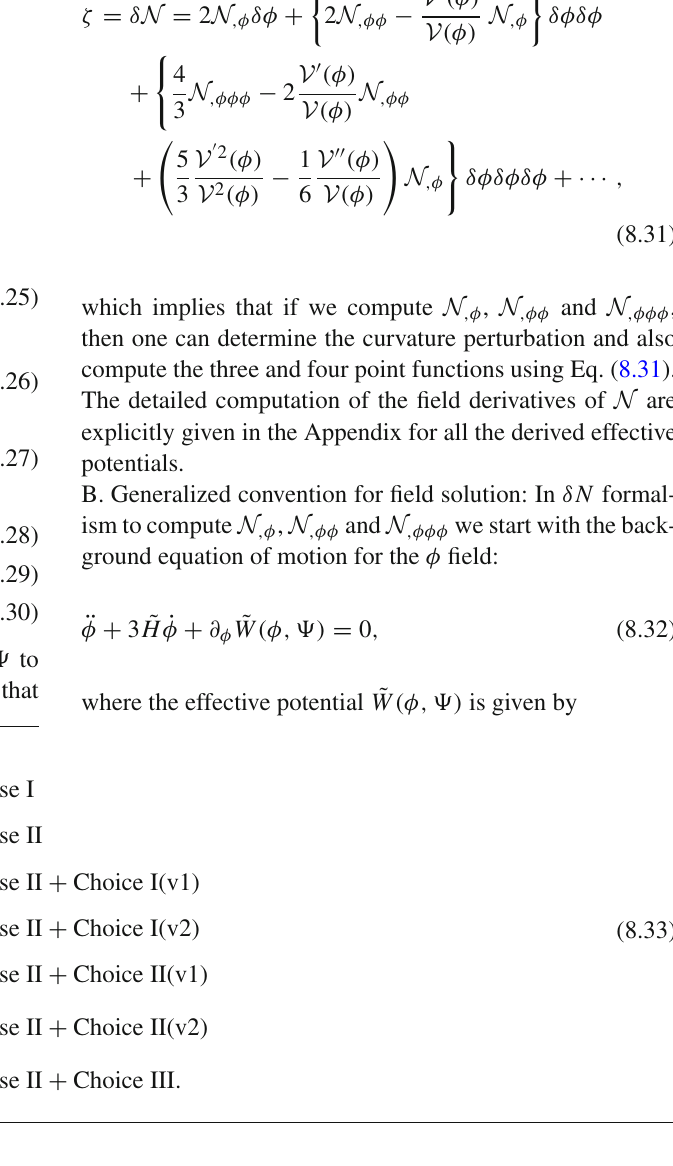
Final uniform energy density hypersurface